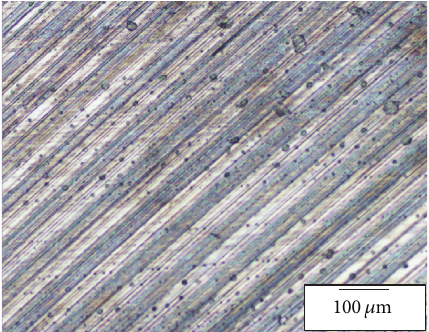
Figure 14: Optical microscopy of the machined surface under spindle speed = 1250rpm, depth of cut = 0.5 mm, and table feed rate = 50 mm/min.